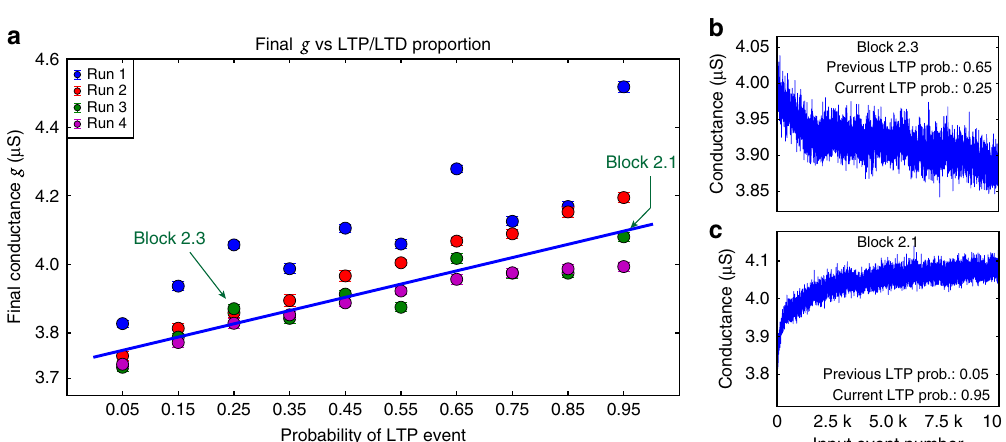
Figure 2 | TiO 2 -based memristors encode conditional probabilities. ( a ) Final memristor conductance after application of 10 4 input event blocks featuring different LTP/LTD compositions. Blue line corresponds to linear fit for runs 2–4. Error bars: s.d., number of samples (individual resistive state readings) per data point n ¼ 25. Typical traces showing resistive state migration during two typical blocks: ( b ) one where the device is overall depressed (third block in run 2: Block 2.3) and ( c ) where it is potentiated (first block in run 2: Block